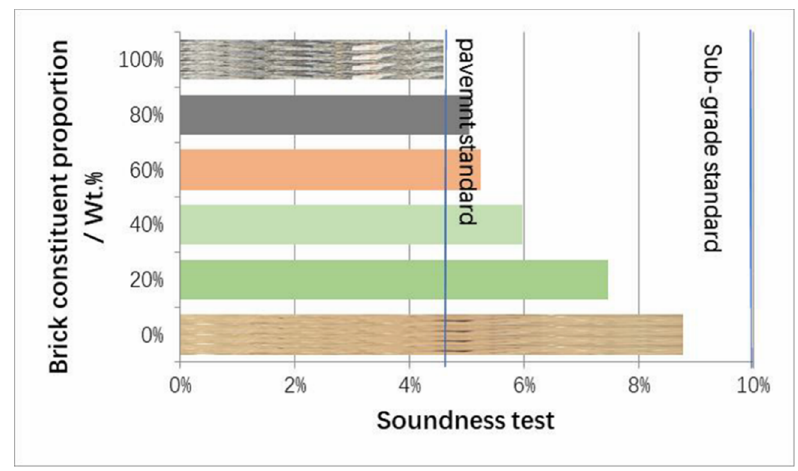
Figure 9. Soundness test of the MRA with brick proportion variations (ASTM C88).